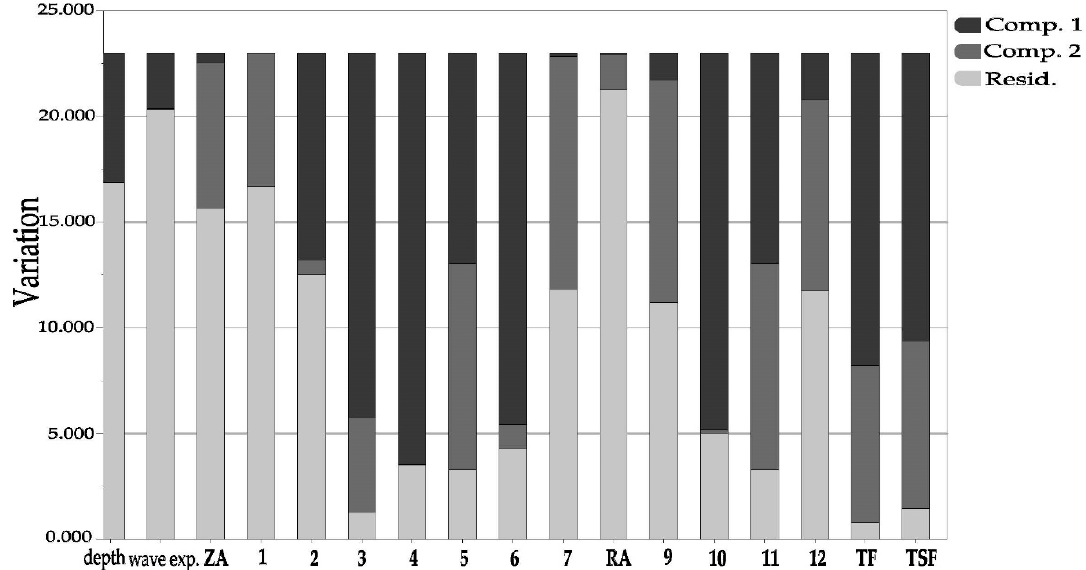
Figure 7. Variation plot for the extracted components 1 (PC1) and 2 (PC2) of the variables in the Zostera marina dataset. See Figure 1 for structures.